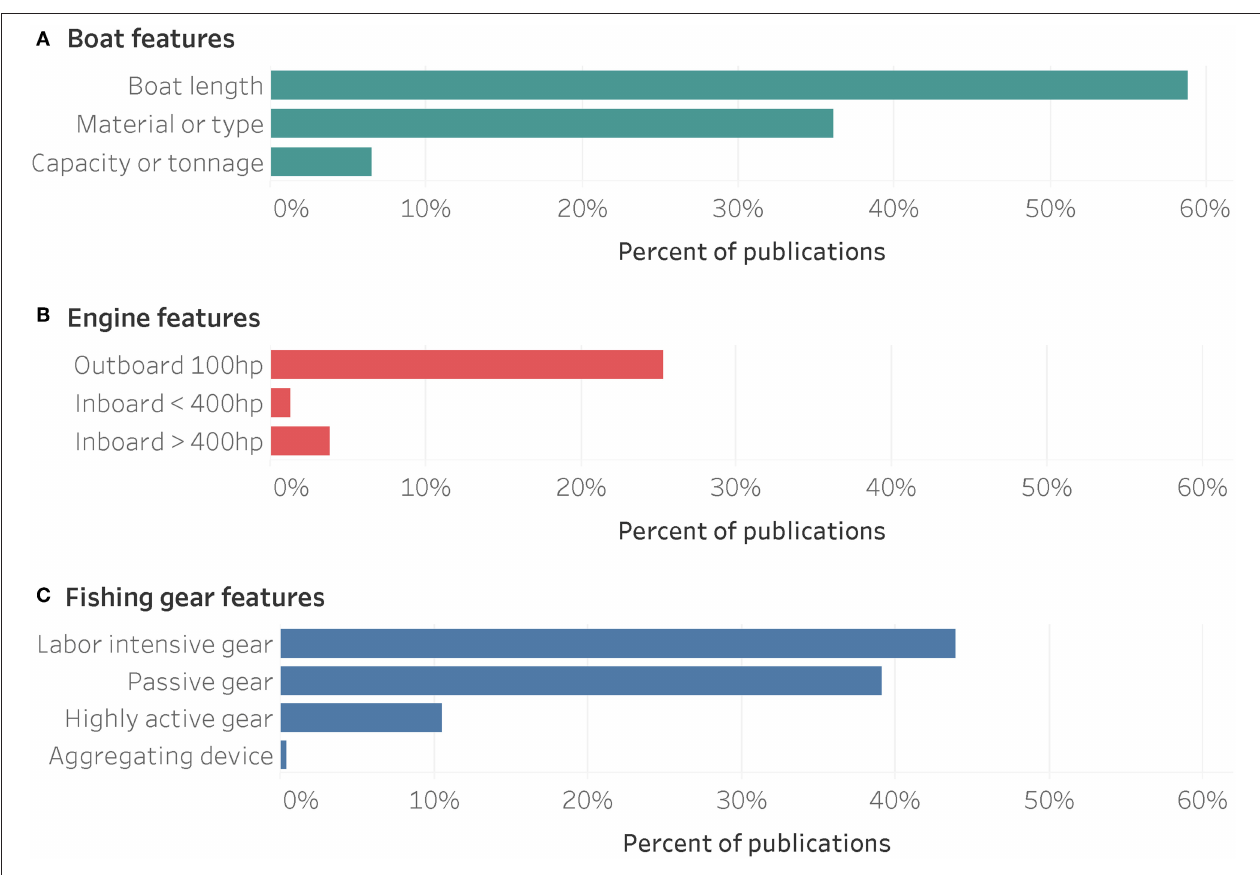
FIGURE 7 | The breakdown of different features used in definitions that relied on fishing boats (A) , engines (B) , and fishing gear (C) to define